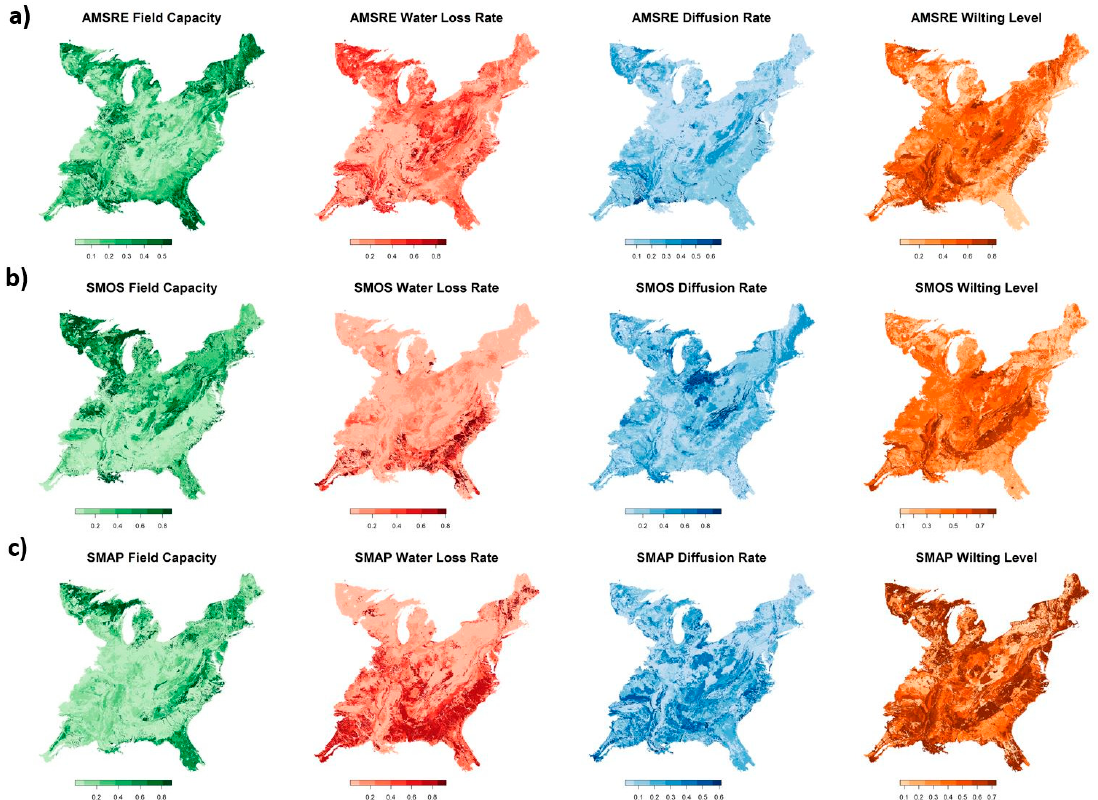
Figure 6. Regional maps of SMAR parameters generated with predictions from trained neural network models arranged by the parameters (left to right): S C1 , a , b , and S W for ( a ) AMSRE-, ( b ) SMOS-, and ( c ) SMAP-estimated parameters.